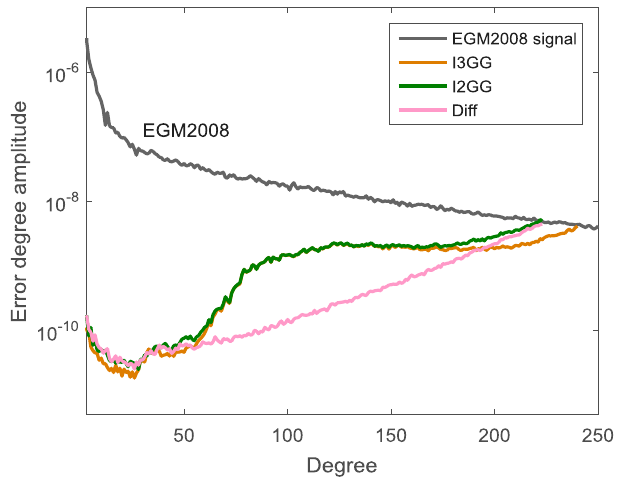
Figure 4. Difference degree amplitudes of the gravity field models I3GG and I2GG compared to the EGM2008.